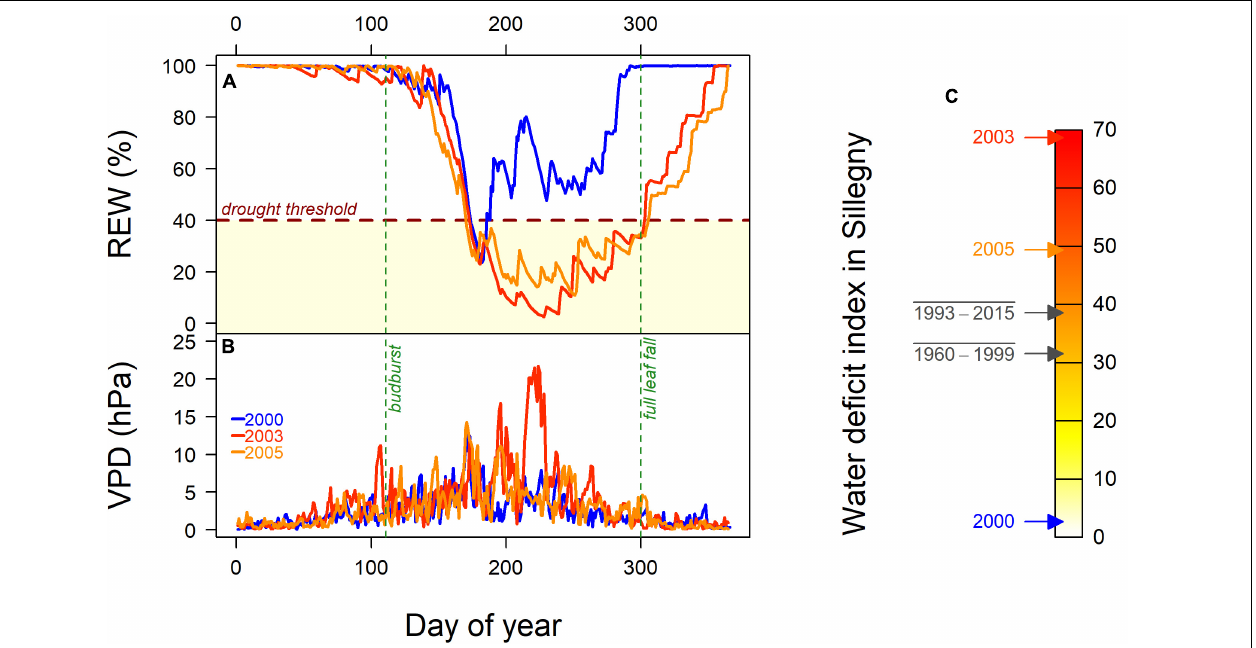
FIGURE 2 | (A) Course of the daily soil Relative Extractable Water (REW, %) calculated by BILJOU© and (B) daily Vapor Pressure Deficit (VPD, hPa) in the common garden of Sillegny in 2000, 2003, and 2005. The red horizontal dashed line represents the drought threshold at 40% of REW. The date of budburst (DoY 111) and full leaf fall (DoY 300) are indicated with dotted vertical green. The annual Water Deficit Index (WDI), which cumulated daily values from budburst to leaf fall, is shown (C) for the three selected years and for the periods 1993–2015 (i.e., the period of tree growth in the common garden) and 1960–1999 (to be compared to the values calculated for the provenance sites; see Supplementary Table 1